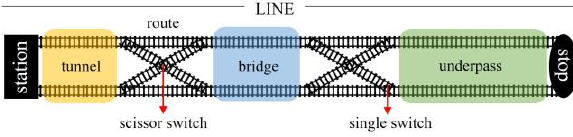
Figure 3. Railway network breakdown (adapted from Papathanasiou et al.,